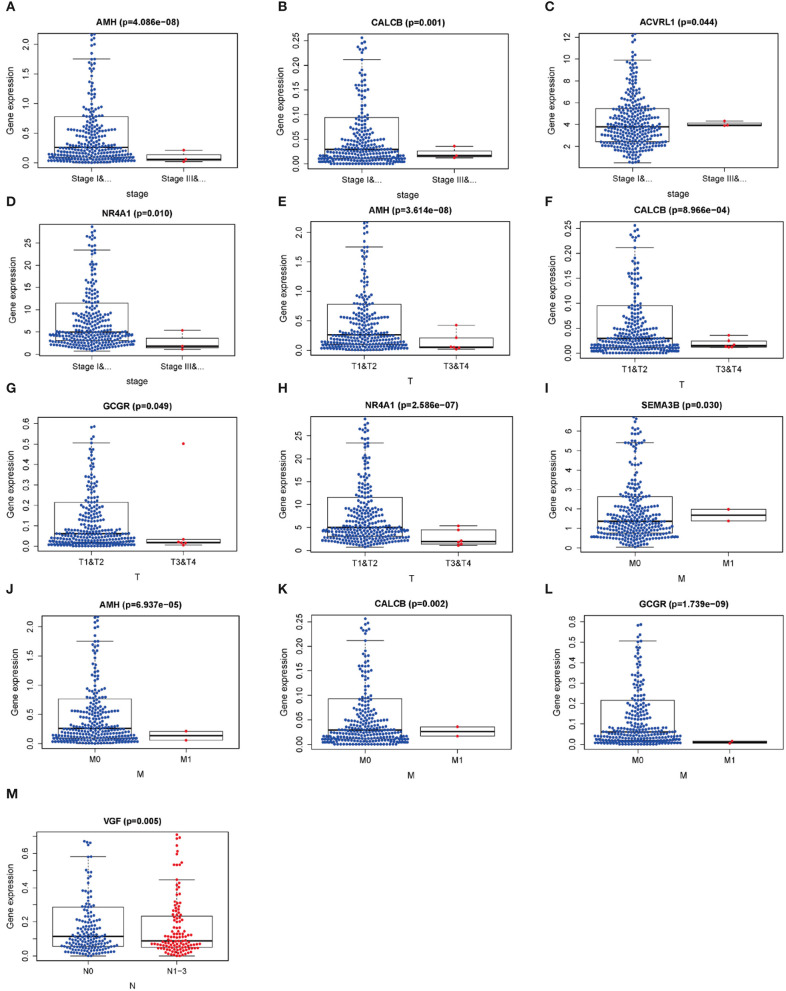
Relationships between the clinical-pathological characteristics and the expressions of differential expression IRGs in LUSC. (A–D) Differences in the expression of DEIRGs between the pathological TNM stages I-II/III-IV in LUSC. (E–H) Differences in the expression of DEIRGs between the pathological T1-T2/T3-T4 stages in LUSC. (I–L) Differences in the expression of DEIRGs between the pathological M0/M1 stages in LUSC. (M) Differences in the expression of DEIRGs between the pathological N0/N1-N3 stages in LUSC.